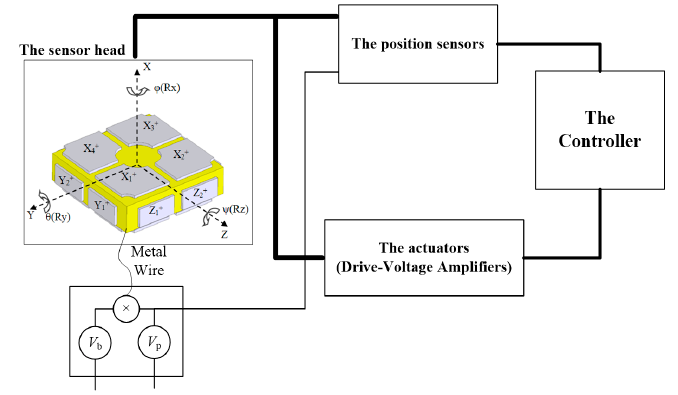
Figure 2. Schematic of HUST electrostatic accelerometer.